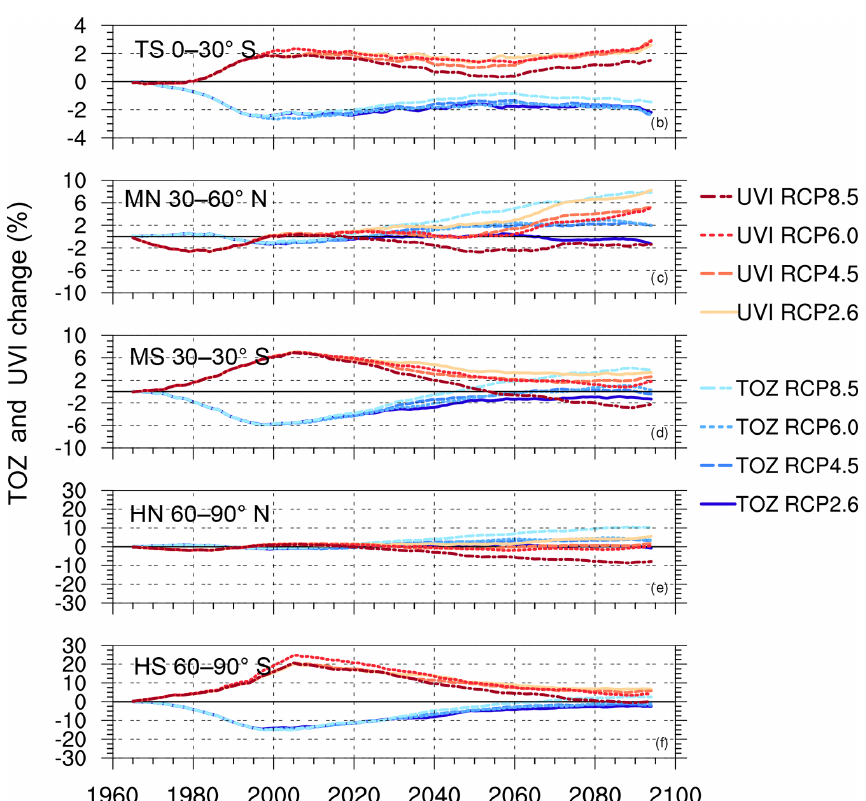
Figure 4. UVI and TOZ percent change in 2090–2100 relative to 1960–1970 values for six latitudinal bands: northern tropical band (TN, 0–30 ◦ N), southern tropical band (SN, 0–30 ◦ S), northern mid-latitude band (MN, 30–60 ◦ N), southern mid-latitude band (MS, 30–60 ◦ S), northern high-latitude band (HN, 60–90 ◦ N), southern high-latitude band (HS, 60–90 ◦ S). UVI changes are represented in different shades of blue for the four RCP scenarios. TOZ changes are represented in different shades of red. Scales of the vertical axes are not the same for each